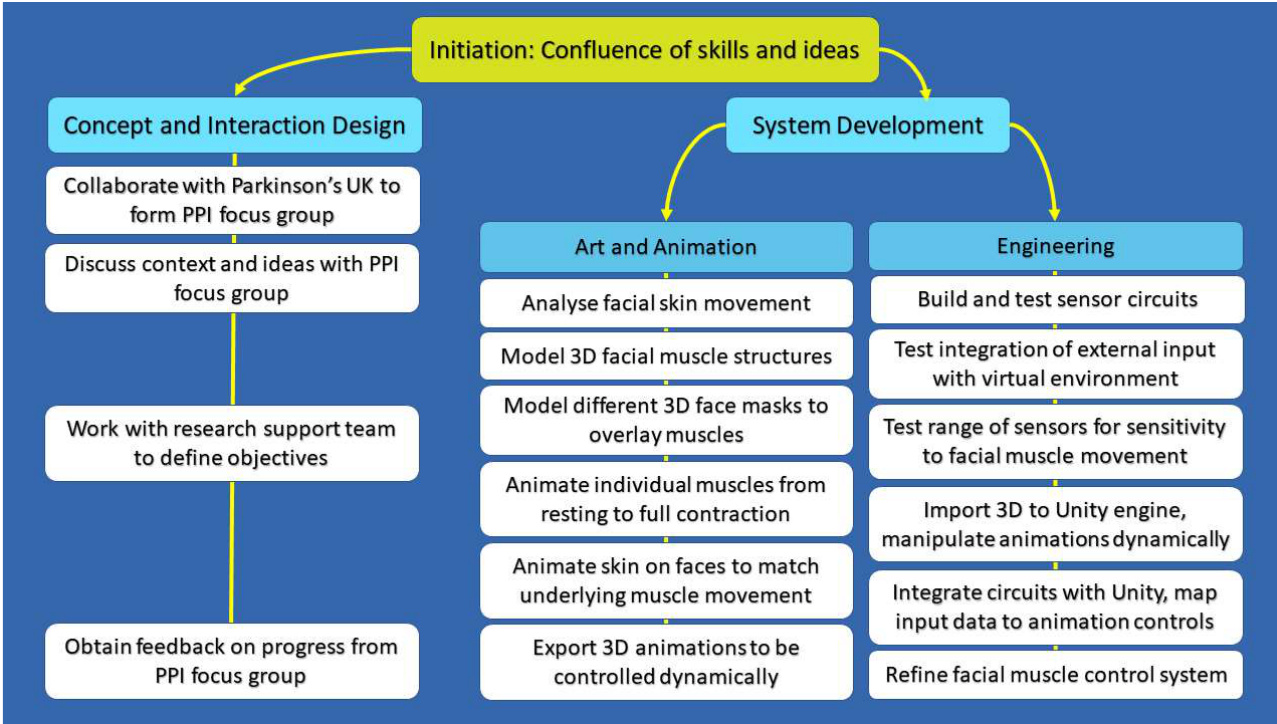
Figure 2. Project Flow Diagram: Showing Interaction Design and System Development occurring